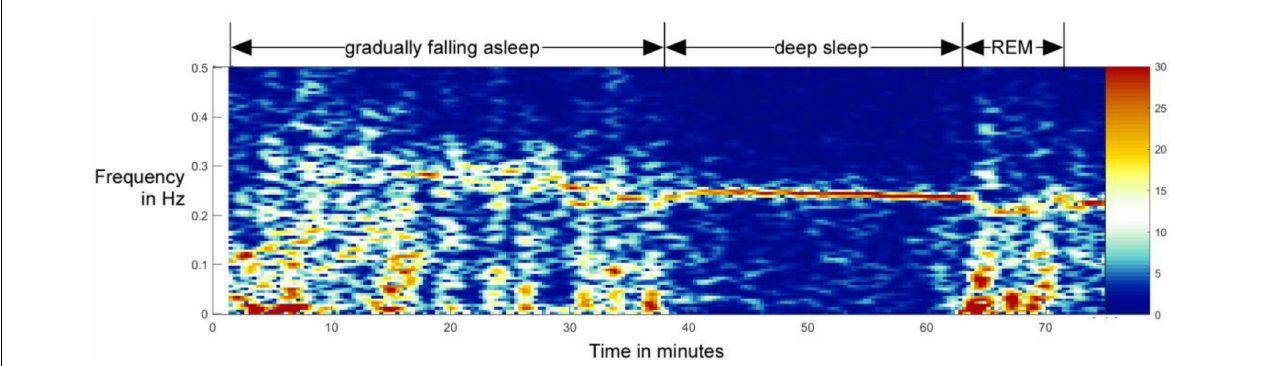
FIGURE 1 | Example of the transition from awake state to non-REM sleep and later to REM sleep in a 10-year-old boy. In this spectral analysis of HRV, one can clearly see the gradual formation and increase of RSA as a band around 0.25 Hz. Although the total activity is higher during awake state, the activity in the RSA band stands out during the non-REM sleep – falling asleep qualitatively resembles a phase transition normally studied in physics (Bartsch et al., 2012; Penzel et al., 2016). This process is reversed when entering the REM stage (from minute 63 on). This figure is not a part of the study reported in this paper, but it was done independently, as part of another study reported in Bonin et al.